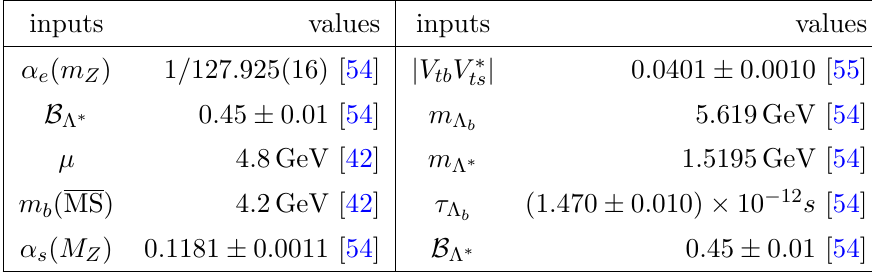
Table 1 . List of inputs and their